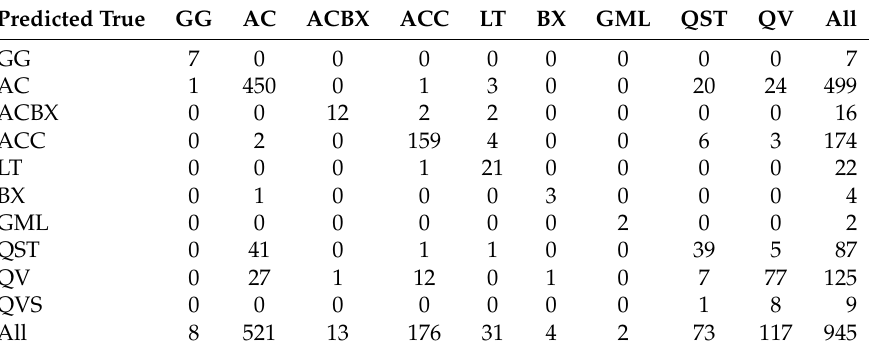
Table 5. kNN model lithology